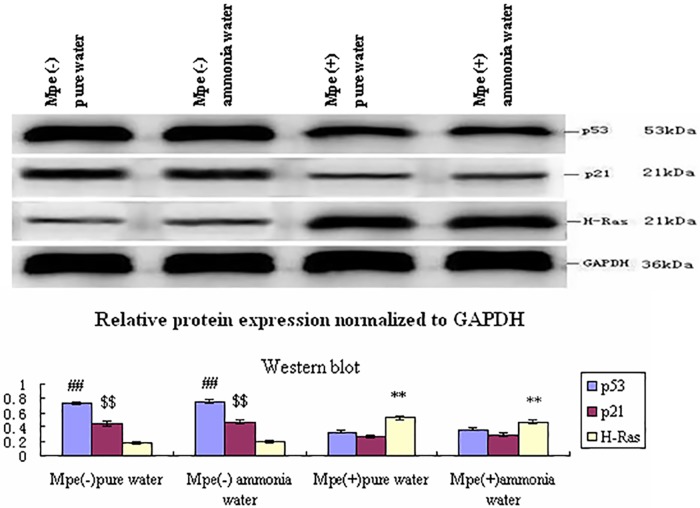
The p53, p21 and H-Ras expression in different groups.Western blot analysis of p53, p21 and H-Ras protein expression in gastric mucosa of Mpe infected and uninfected mice sub-groups. Data is representative of three independent experiments (n = 3). (# <0.01, $ <0.05, * <0.05).